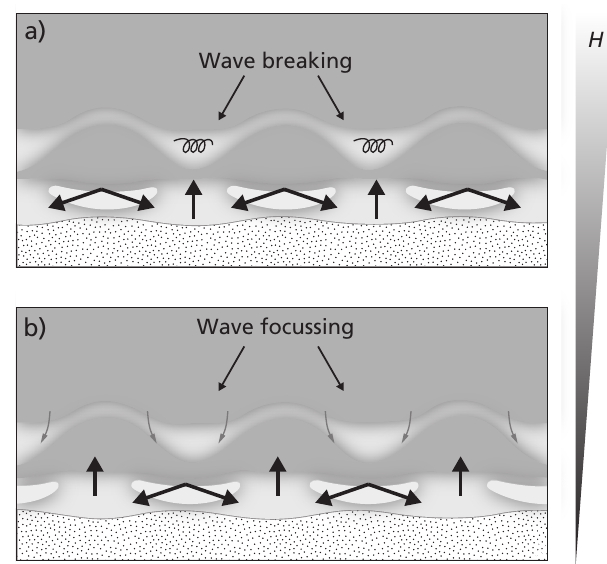
Figure 7. Coupling patterns found by Castelle et al. (2010a), show- ing (a) out-of-phase coupling and (b) in-phase coupling, depending on the wave height H . The thick black arrows indicate the associate flow patterns, whereas the gray arrows indicate wave